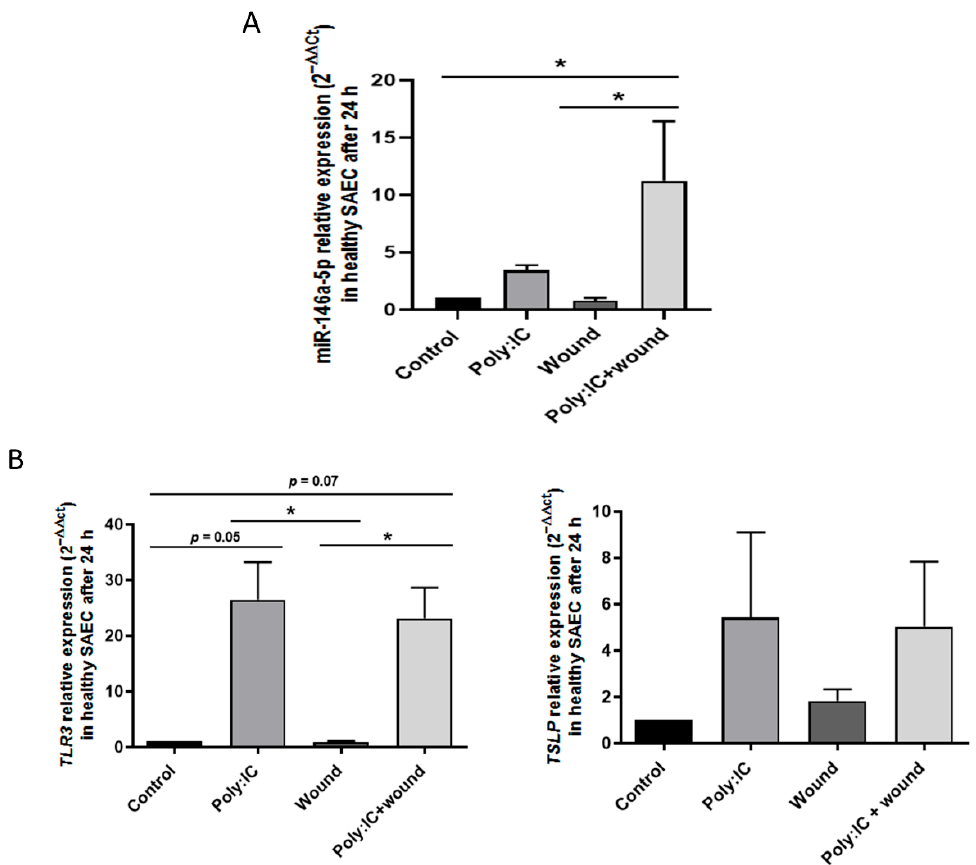
Figure 5. Poly:IC and epithelial wounds produce a synergistic increase in miR-146a-5p ( A ) miR- 146a-5p expression (2 − ∆∆ Ct ) in SAECs influenced by the action of poly:IC (20 ng/mL), epithelial wounds, and combination of both. ( B ) TLR3 and TSLP expression (2 − ∆∆ Ct ) are altered in SAECs after stimulation with poly:IC (20 ng/mL) and poly:IC plus wounds. SAEC: Small airway epithelial cells. * p < 0.05.